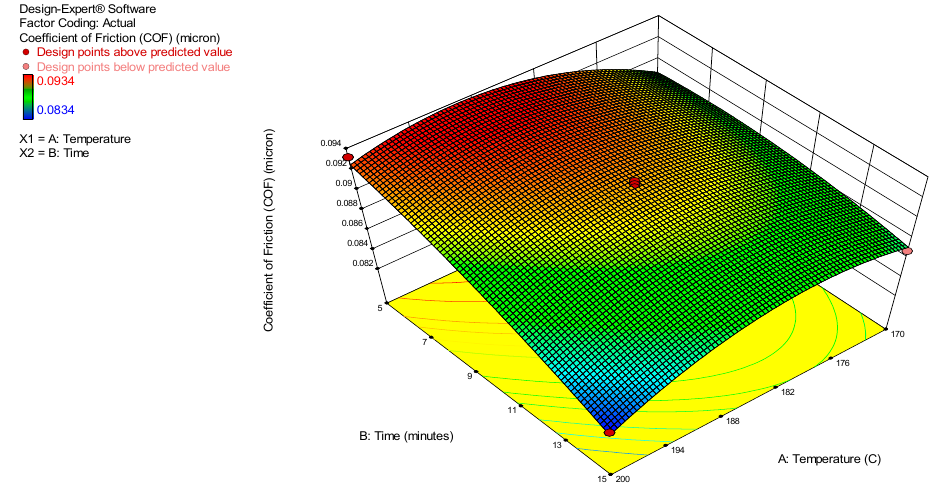
Figure 3. A 3D interaction plot of the COF for the MoS 2 nanolubricant.